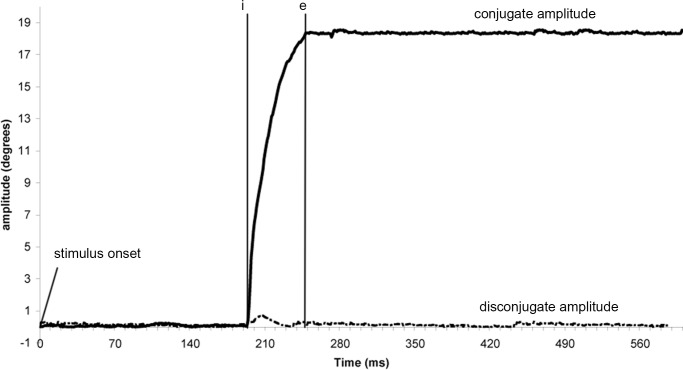
Typical recording of a saccade eye movement.Markers ‘i’ and ‘e’ indicate the onset and the offset of vergence eye movement based on the criterion of 45°/s velocity threshold. Full line: conjugate amplitude; dotted line: disconjugate amplitude.